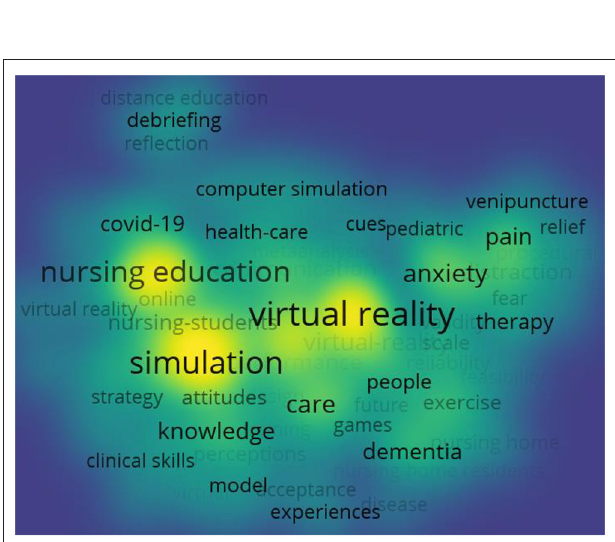
FIGURE 7 | The density visualization of keywords in publications on the application of VR in nursing from 2012 to 2021. A keyword with higher frequency counts forms a yellow region, and those with lower frequency counts form a blue